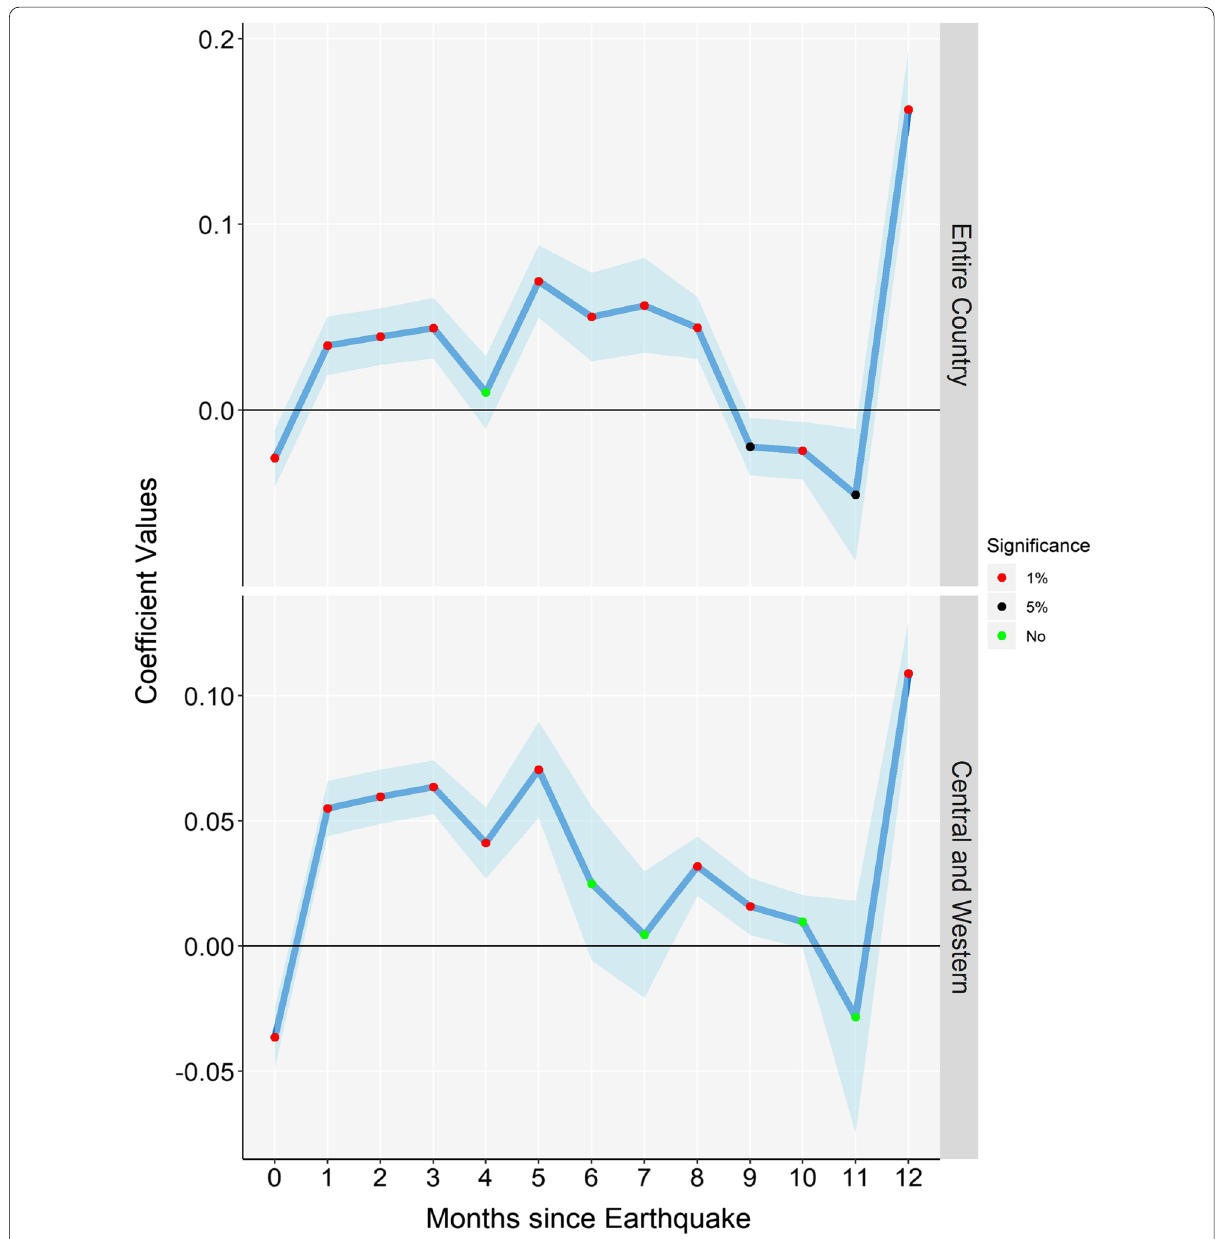
Fig. 7 Regression results for Nepal and the Central and Western